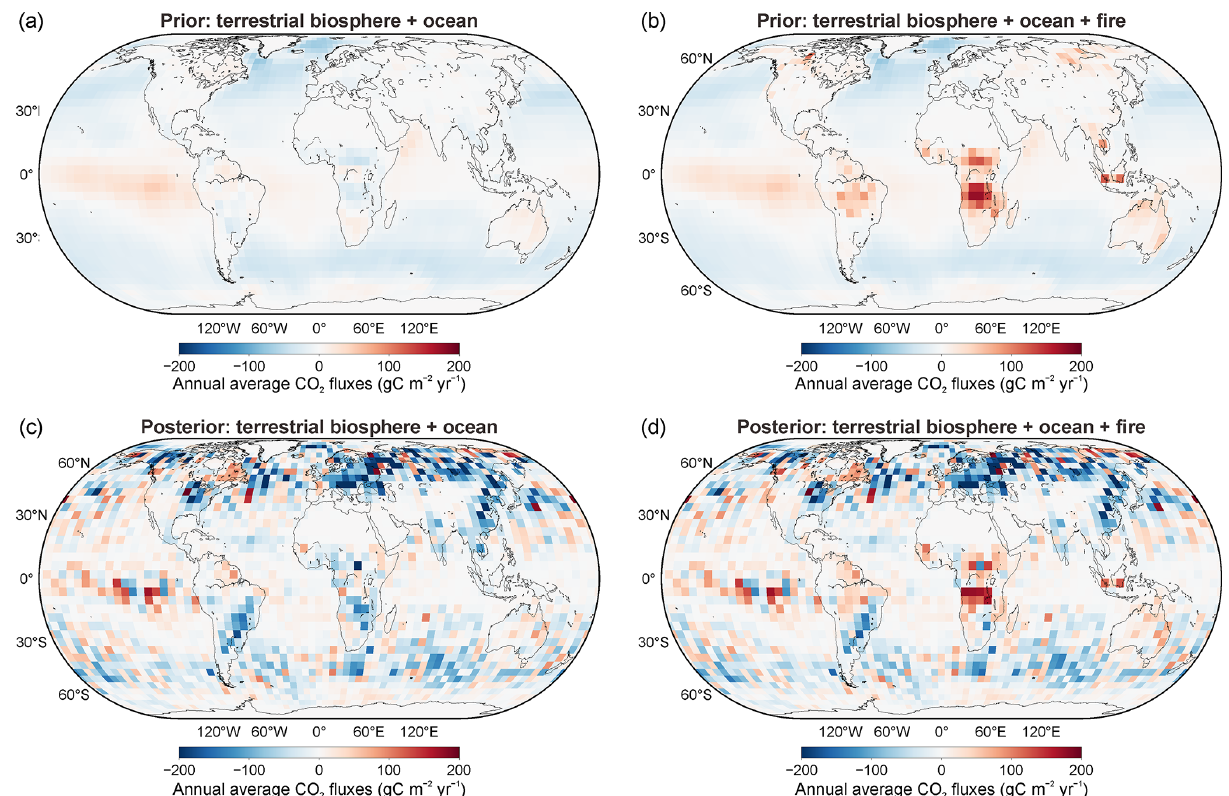
Figure 4. Spatial distribution of global natural carbon fluxes from 2015 to 2020. The annual average carbon fluxes derived from 2015 to 2020 are shown at a spatial resolution of 4 ◦ latitude × 5 ◦ longitude. Panel (a) displays the prior terrestrial biospheric + oceanic fluxes used in the reference inversion system. Panel (b) shows the prior terrestrial biospheric + oceanic + fire fluxes (the fire fluxes were prescribed in the inversion system). Panel (c) shows the posterior terrestrial biospheric + oceanic fluxes derived from the reference inversion system. Panel (d) shows the posterior terrestrial biospheric + oceanic + fire